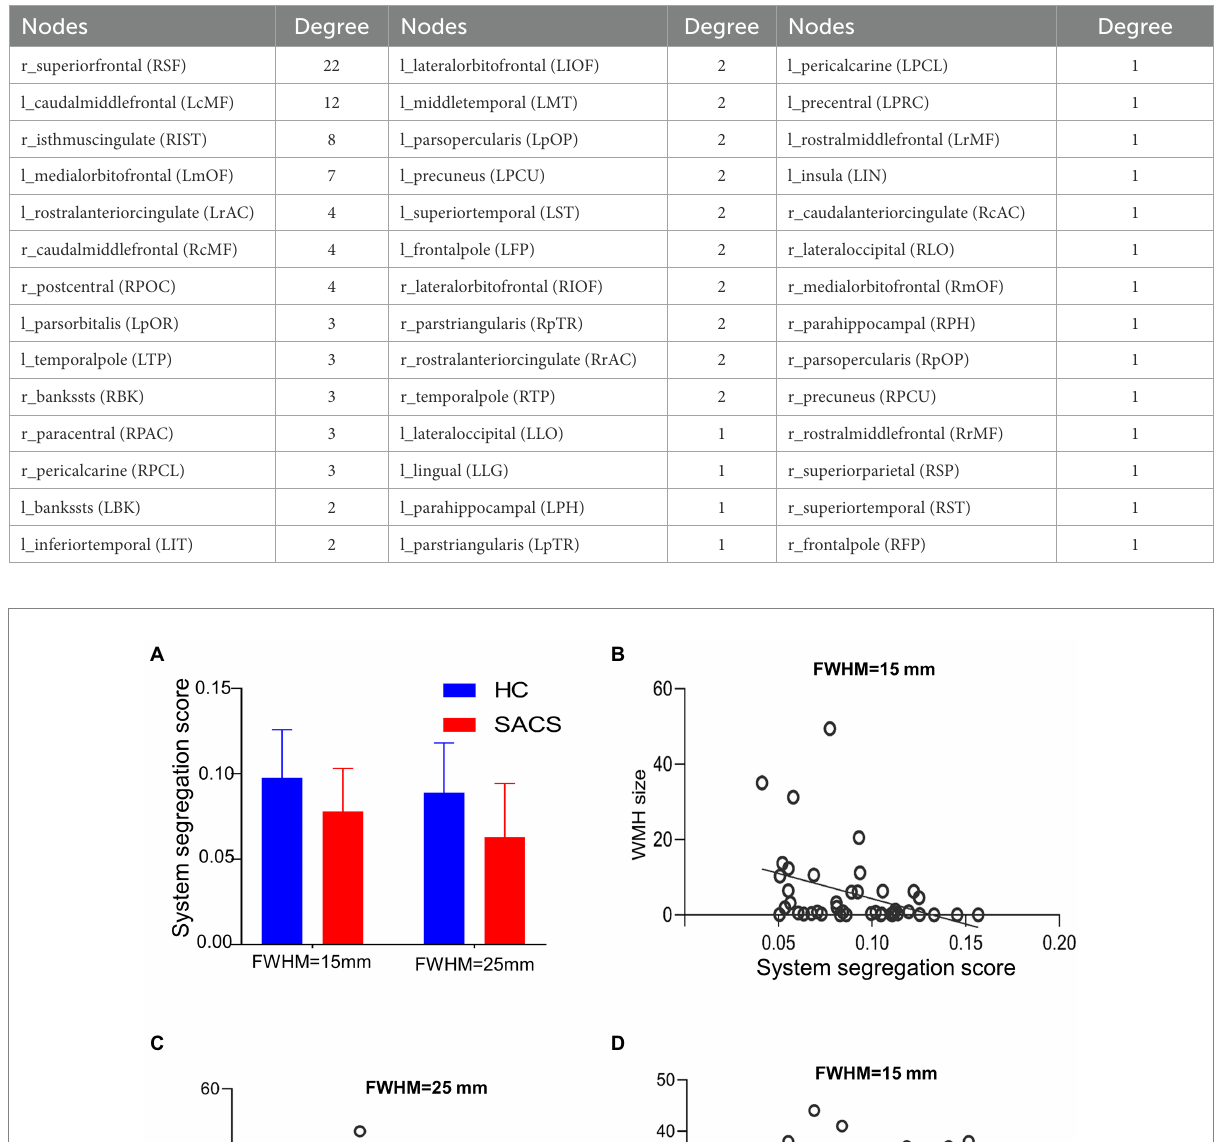
TABLE 2 Nodes with reduced connections and their